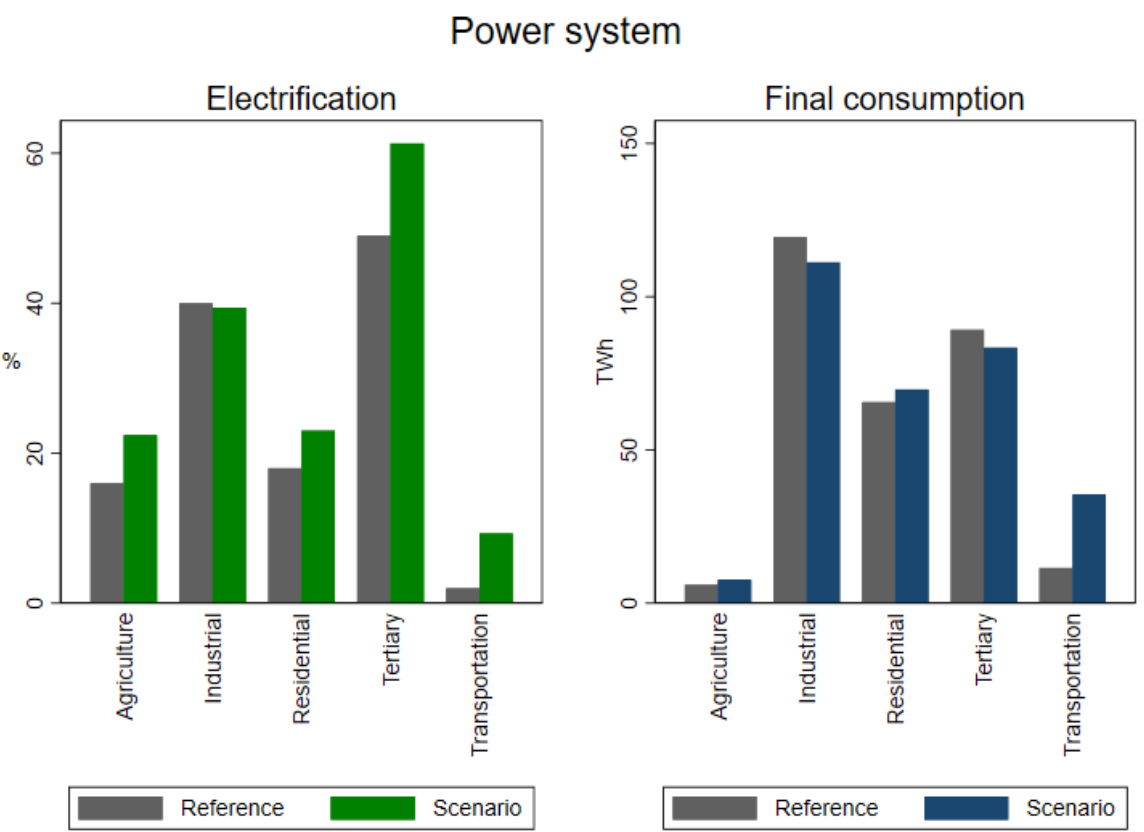
Figure 3. Final energy consumption and electrification.